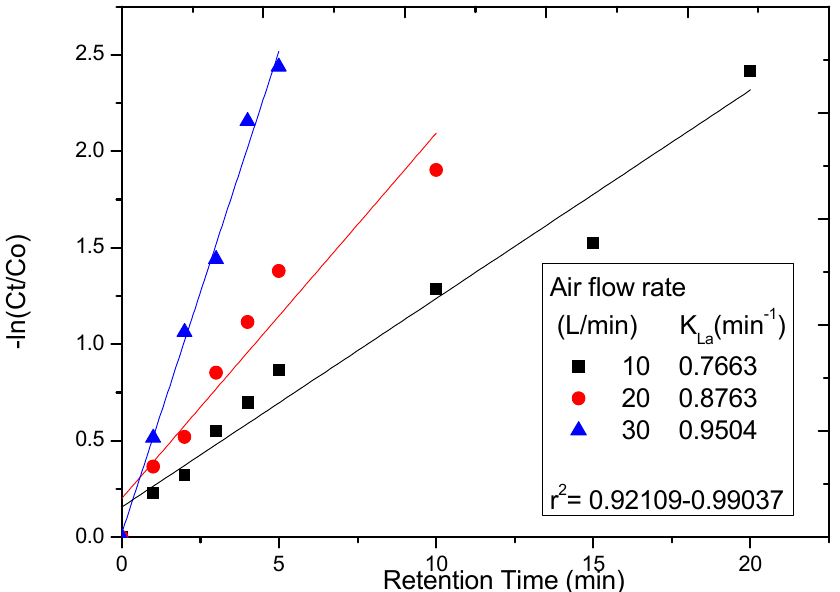
Figure 7. Effect of air flow rate on the K L a . (Initial HFC-134a conc.: 772 mg/L, liquid circulation rate: 80 L/min).